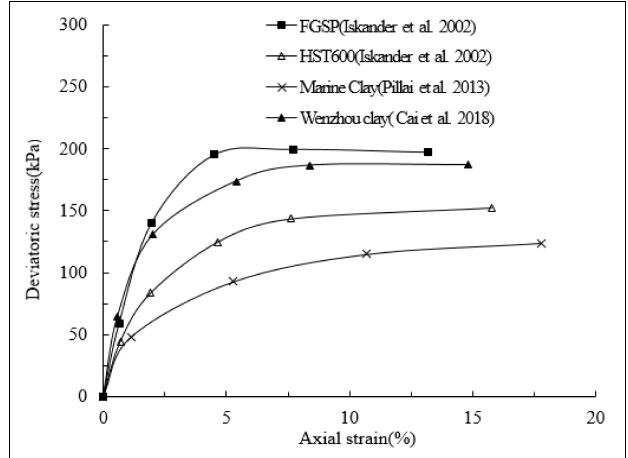
FIGURE 1 | Stress–strain responses of amorphous silica and some natural